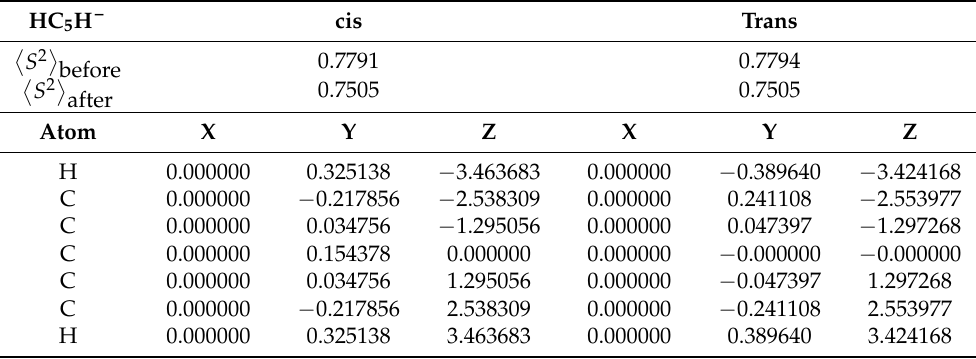
Table A3. Cartesian coordinates in Å of the cis and trans HC 5 H – anion conformers optimized at the